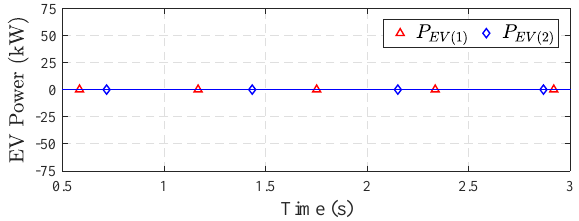
Figure 18. EV power profiles during reactive operation.